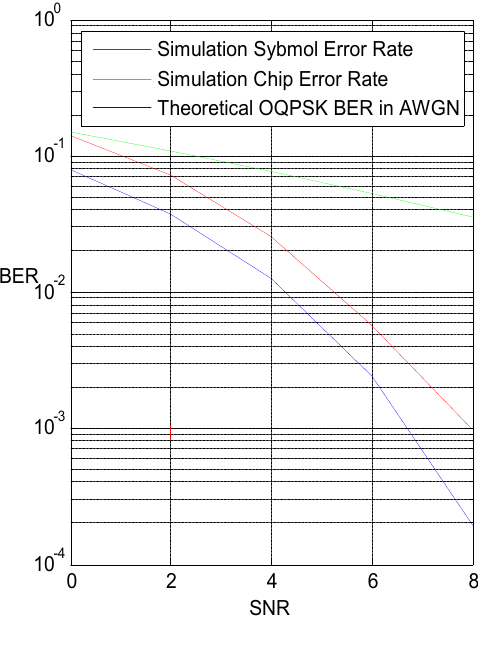
Figure 8. Estimated position of the BER curve when fading channel and interleavers and deinterleavers are present in communication